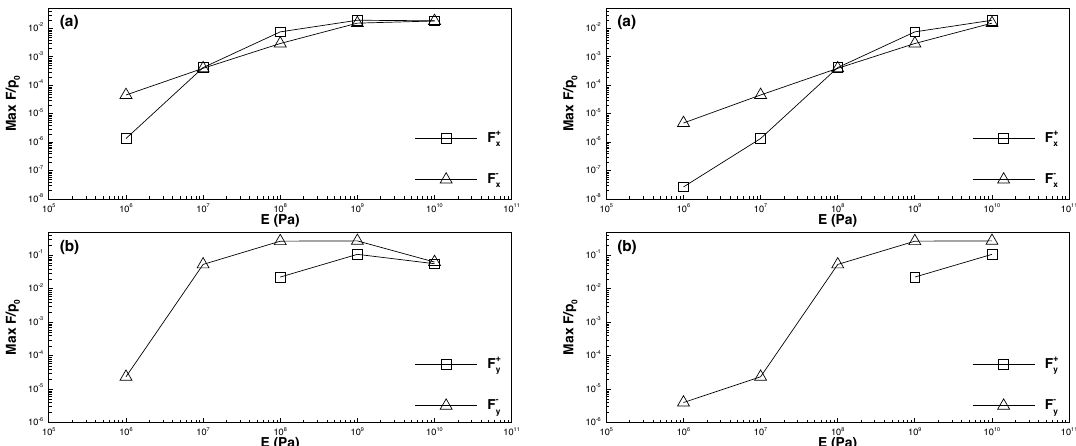
Figure 17. Maximum force on the pipeline in relation to Young’s modulus; left : k = 1.0 × 10 − 5 m/s; right : k = 1.0 × 10 − 6 m/s. ( a ) Horizontal component; ( b ) vertical component.